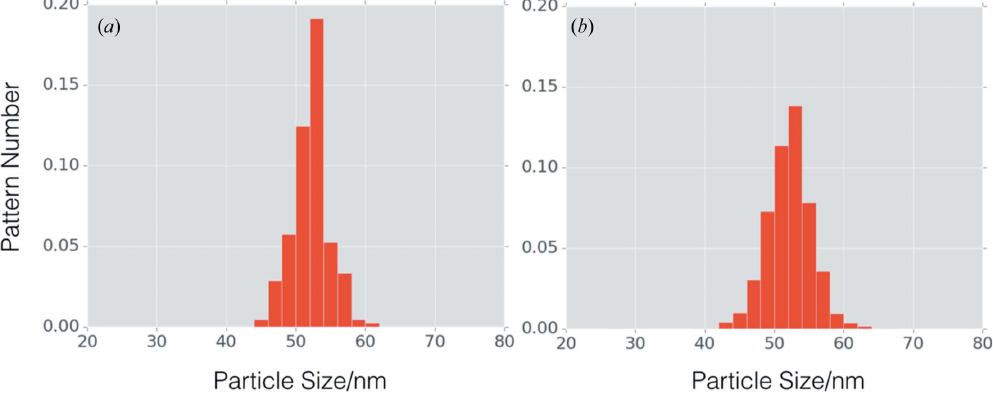
Figure 6 Particle size distribution. ( a ) Size distribution of particles in normal incidence cases. Note that the distribution is slightly different from the plot given by Li et al. (2017), due to the different number of patterns in the analysis. ( b ) Distribution of particle sizes in the general incidence case. The two distributions both show that the mean size of particle is approximately 52 nm, consistent with electron microscopy image statistics.